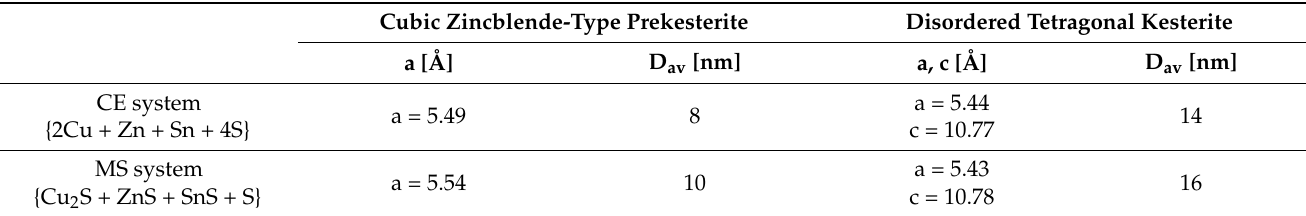
Figure 2. XRD patterns for nanopowders in the MS system: ( left) —cubic zincblende-type prekesterite (F43m); ( right) —disordered tetragonal kesterite (I42m). Table 1. Lattice constants, a and c , and the average crystallite sizes, D av , for cubic rekesterite